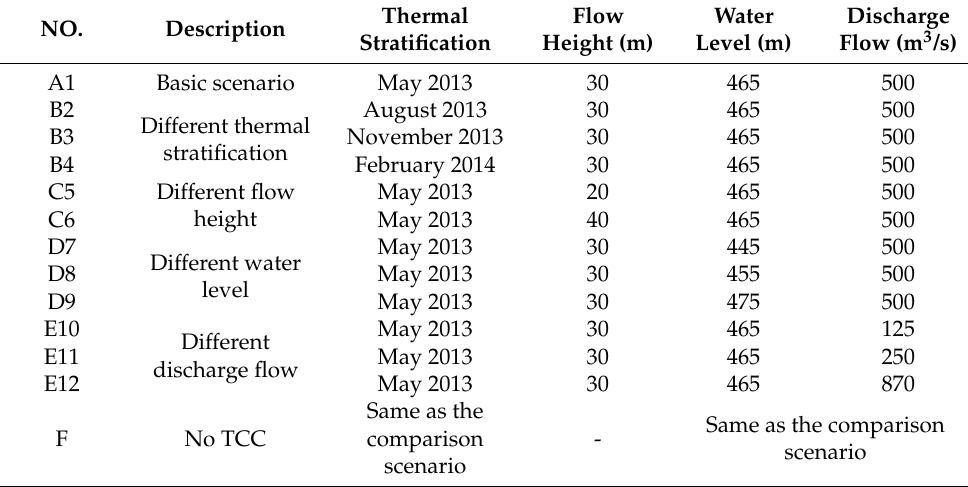
Table 3. The laboratory test scenarios.